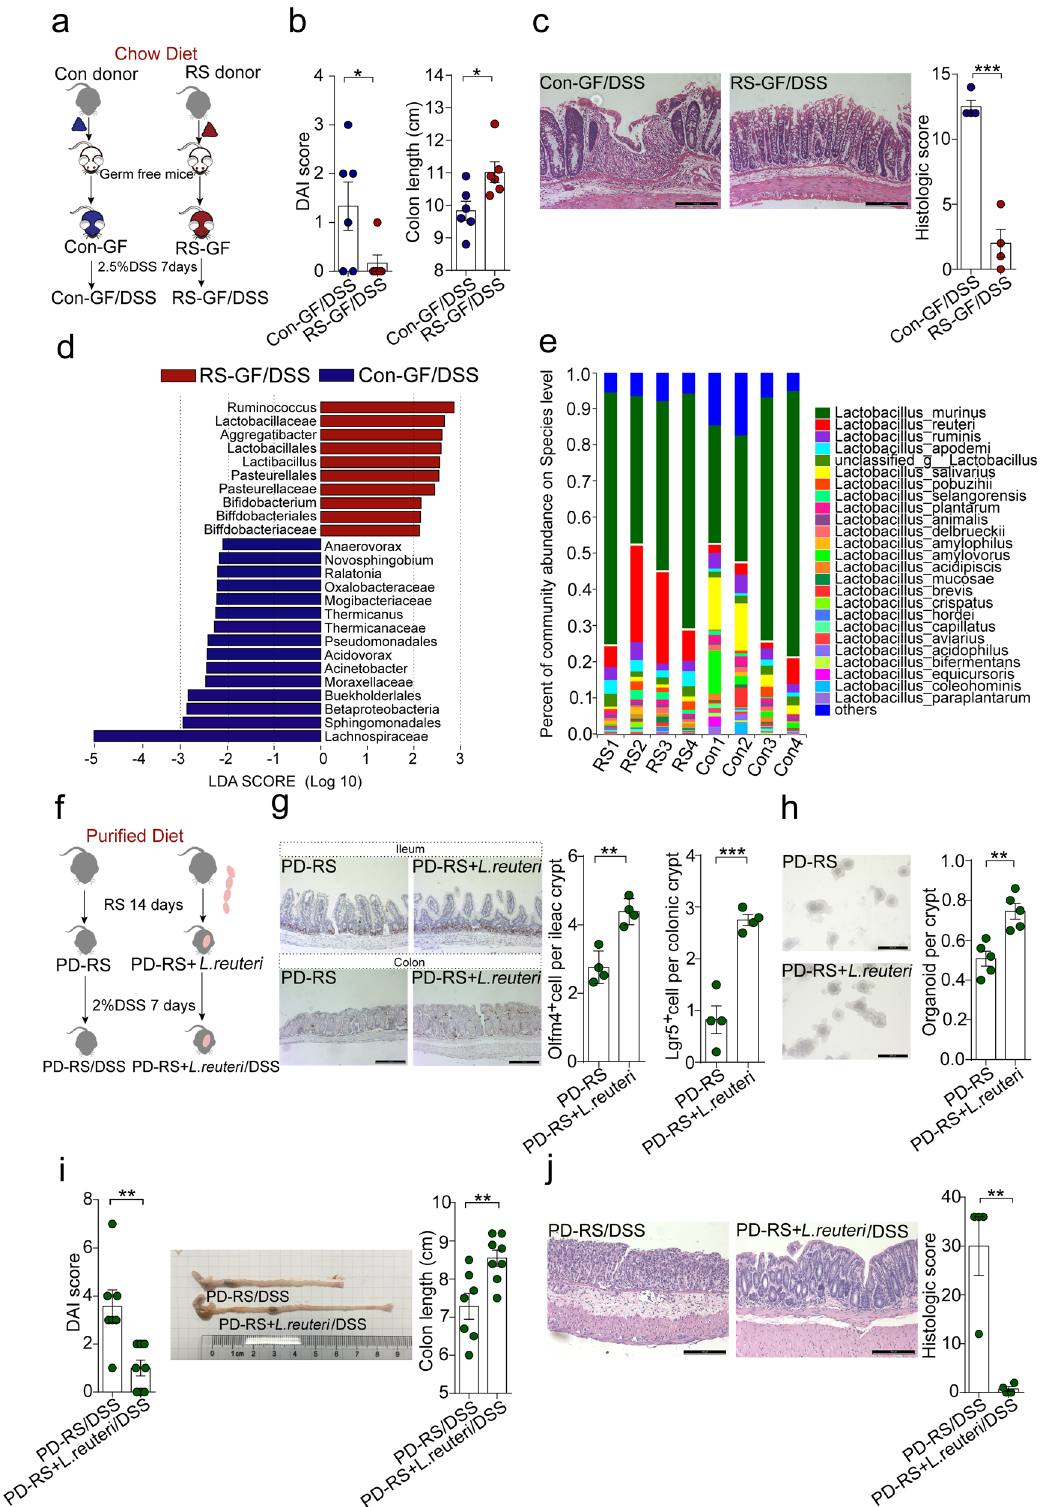
germ-free (GF) recipients and triggered epithelial injury by DSS (Fig. 3a). GF mice transplanted with the fecal microbiota from stressed mice (RS-GF/DSS) showed attenuated colitis phenotypes including DAI, colon length, and crypt density (Fig. 3b, c), sug- gesting that stress-induced adaptive changes in gut microbiota exert a protective effect against chemical injury. Notably, 16S rRNA sequencing of the cecum microbiome from colitis mice